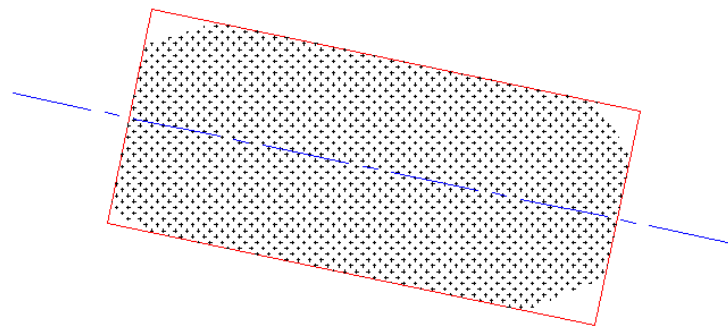
Figure 15. The minimum envelope rectangle of the target points.